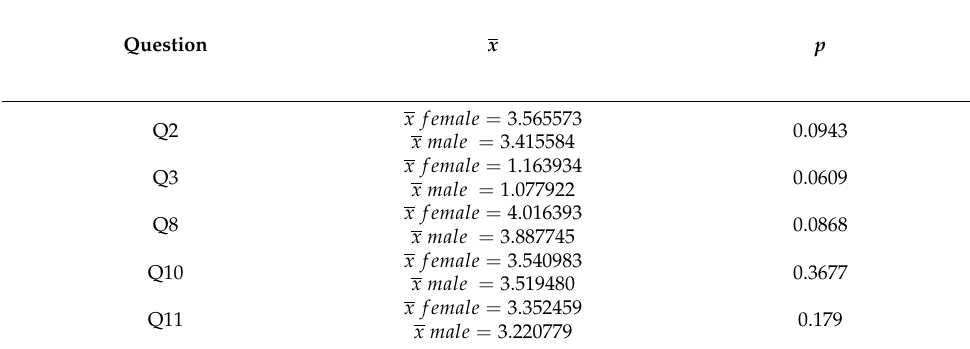
Table 4. Mean values x and p values for questions Q2, Q3, Q8, Q10 and Q11.